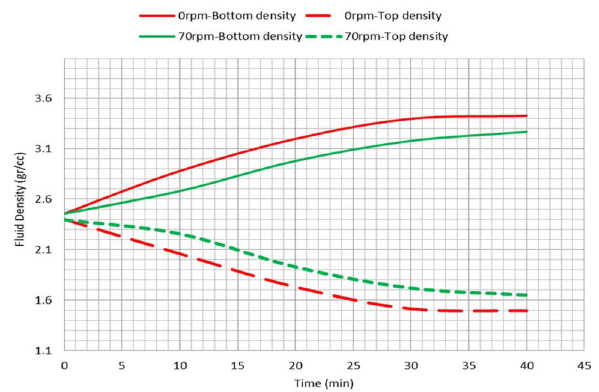
Fig. 5 Changes in the concentration of barite particles in the upstream and downstream of the circulating loop (flow rate of 0.308 l/s and deviation angle of 60°)